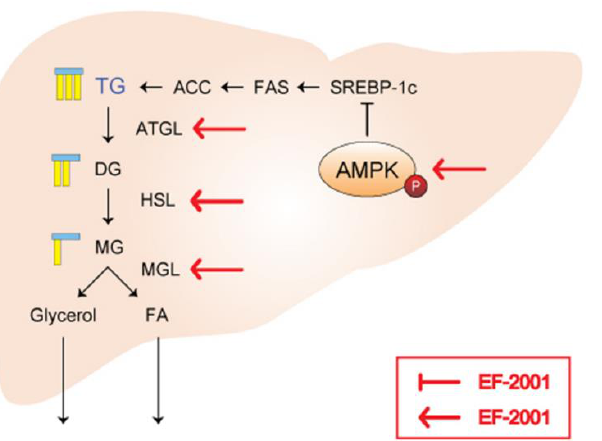
Figure 9. Schematic diagram of the mechanism of EF-2001 on FL83B hepatocytes and HFD-induced hepatic steatosis.